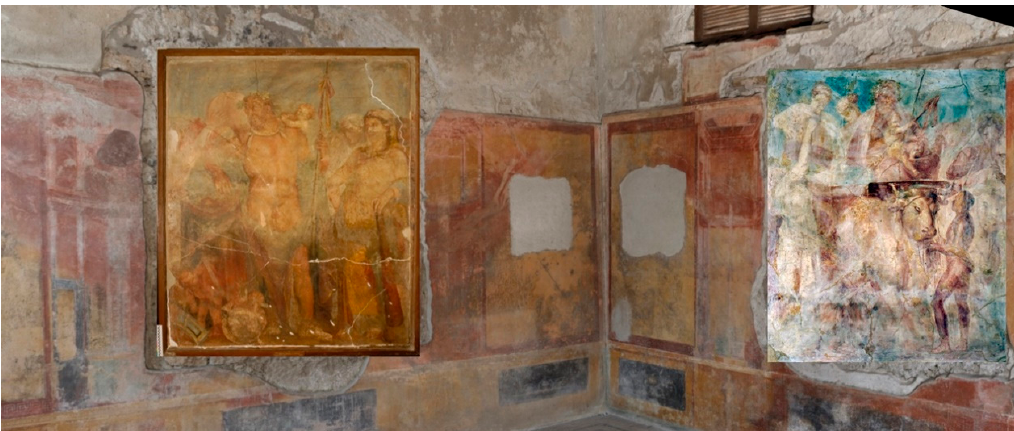
Figure 12. Room 16, east wall and west wall. Edited screenshot showing the detail of the embedded wall paintings from the Museo Archeologico Nazionale di Napoli . Model Courtesy: Kelly McClinton. Image Courtesy: photos for the 3D model on concession of the Ministero dei Beni e delle Attività Culturali e del Turismo, Parco Archeologico di Pompei (used by permission).